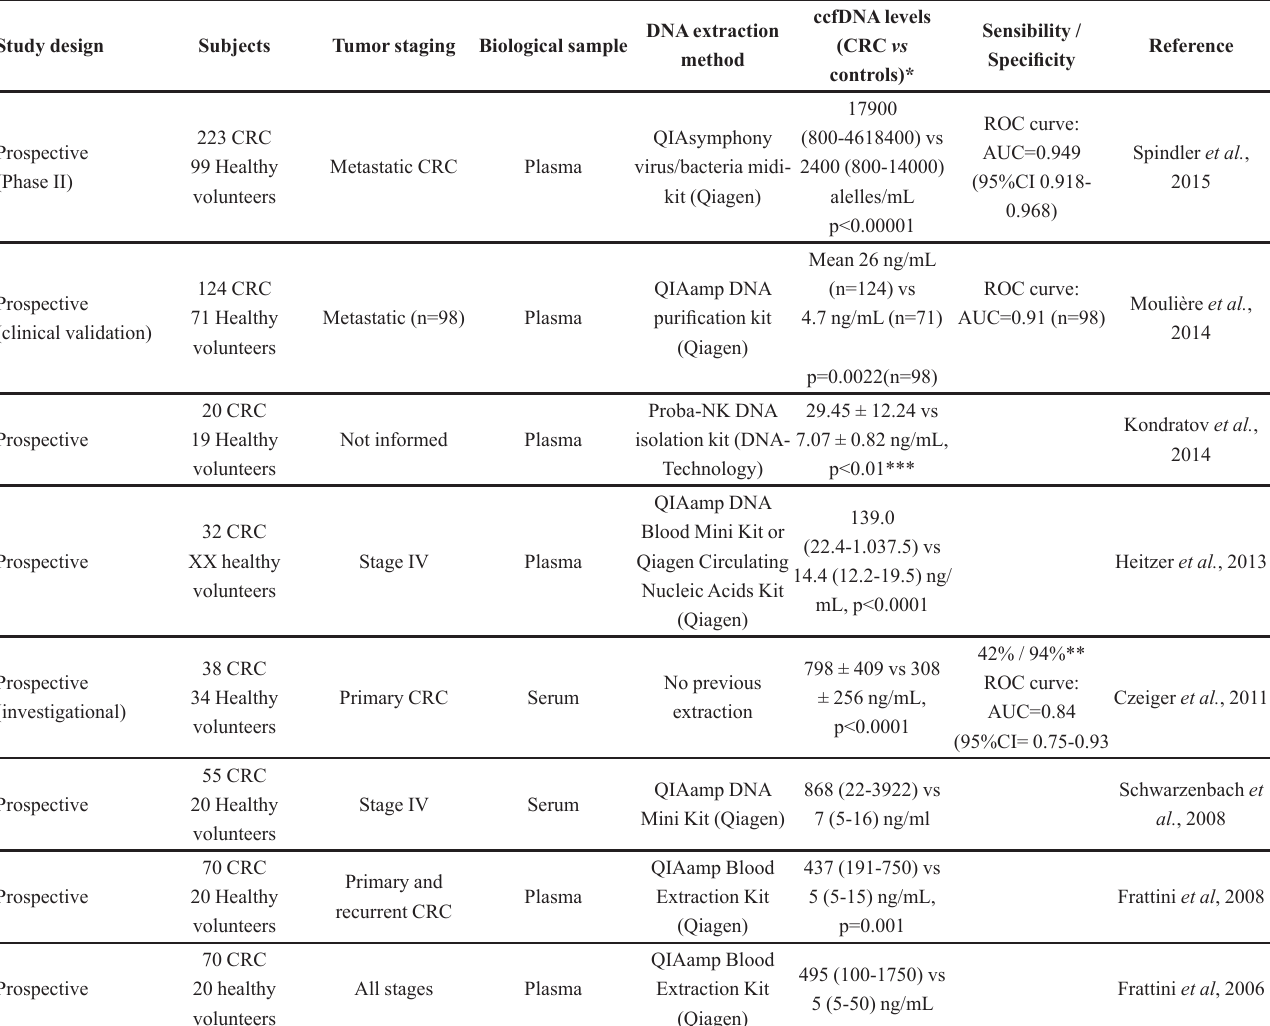
TABLE II - Clinical studies that evaluated the ccfDNA quantification as biomarker for the CRC diagnosis